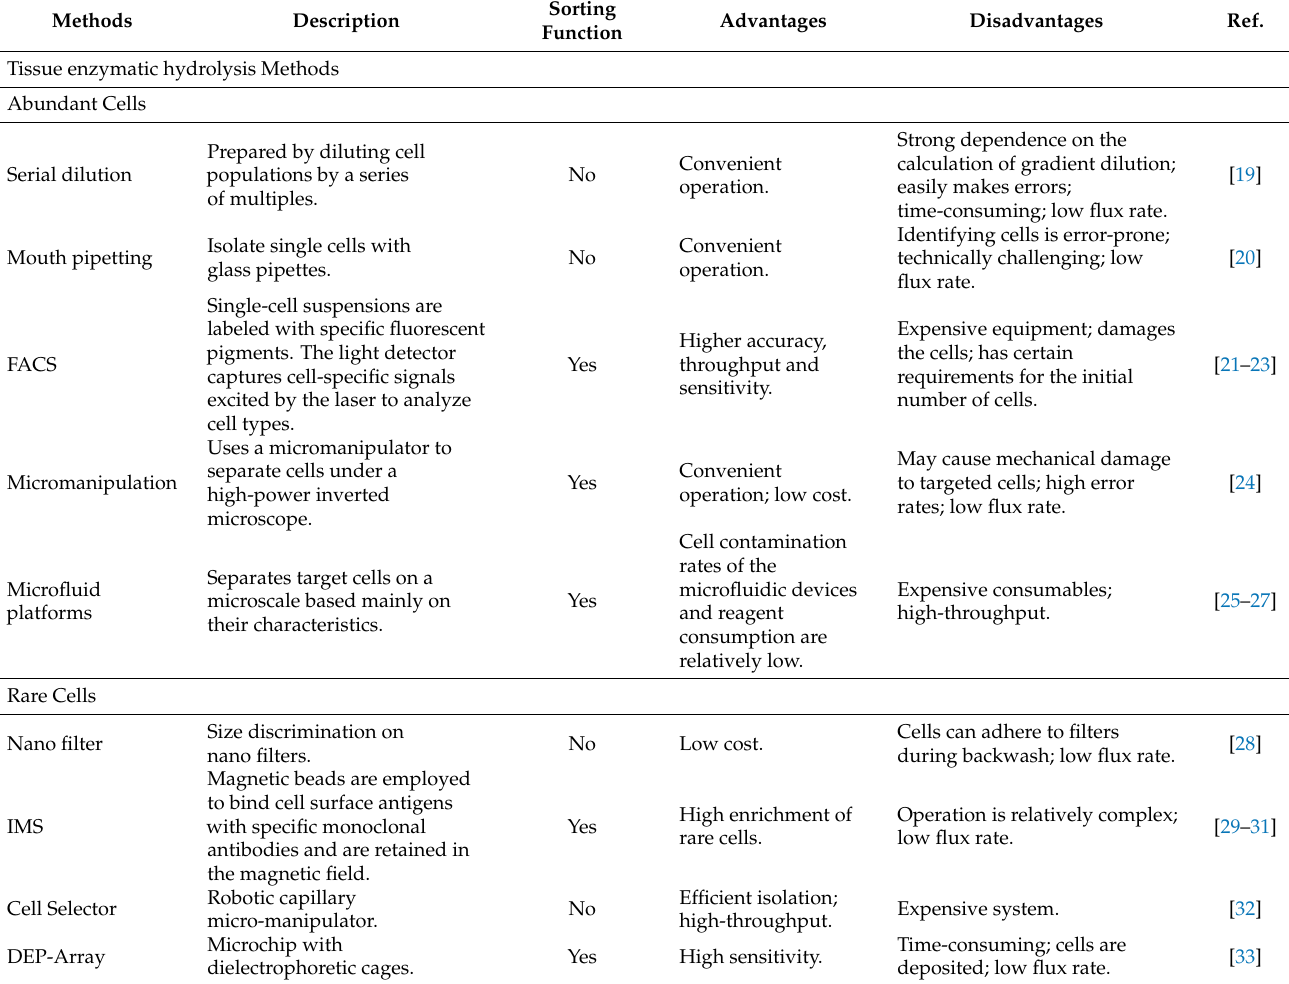
Table 2. Single-cell isolation